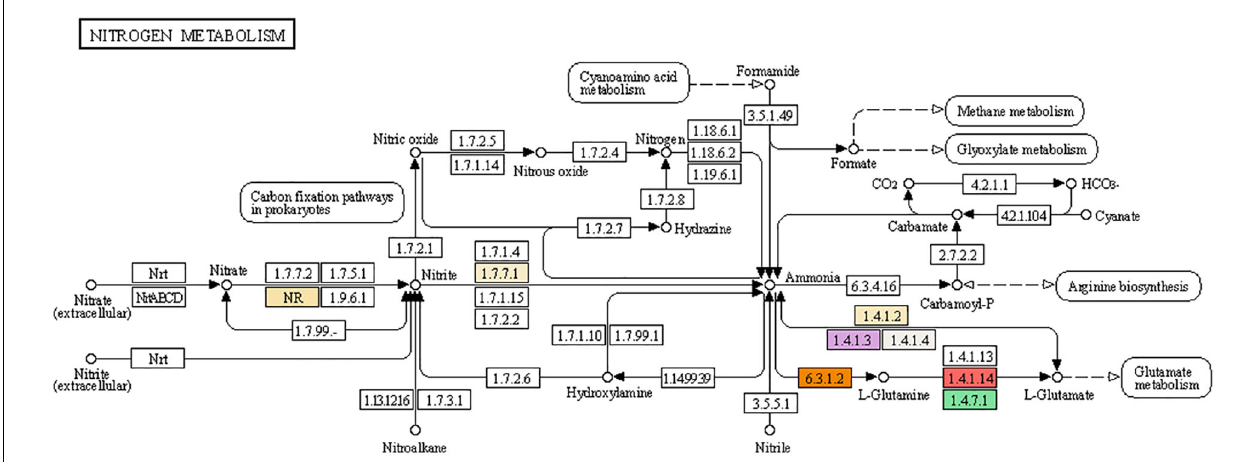
FIGURE 5 | Mechanism of nitrogen assimilation and integrated pathways with different enzymes involved in channelizing nitrate toward amino acids and proteins. Nitrate and nitrite are the primary nitrogen source for cereal crops. Nitrate is converted to nitrite by regulatory enzyme: nitrate reductase (NR, highlighted in creamish color) (1.7.7.2). Nitrite is further reduced to ammonia by nitrite reductase (1.7.7.1, highlighted in creamish color). Ammonia is channelized for amino acid synthesis primarily by action of glutamate dehydrogenase (1.4.1.2, highlighted in creamish color¶and 1.4.1.3, highlighted in purple color). Glutamate is further converted to glutamine by glutamine synthetase (6.3.1.2, highlighted in orange color; 1.4.7.1, highlighted in green color and 1.4.1.14, highlighted in red color). Glutamine and glutamate are the primary amino acids routed for protein synthesis. Partial fraction of ammonia is involved in arginine metabolism using carbamoyl phosphate